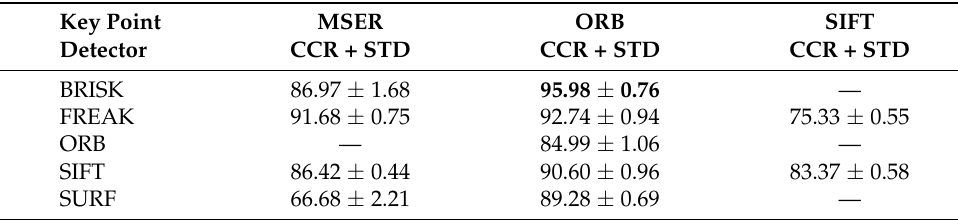
Table 5. Regime B: Evaluation of the methods’ discriminative